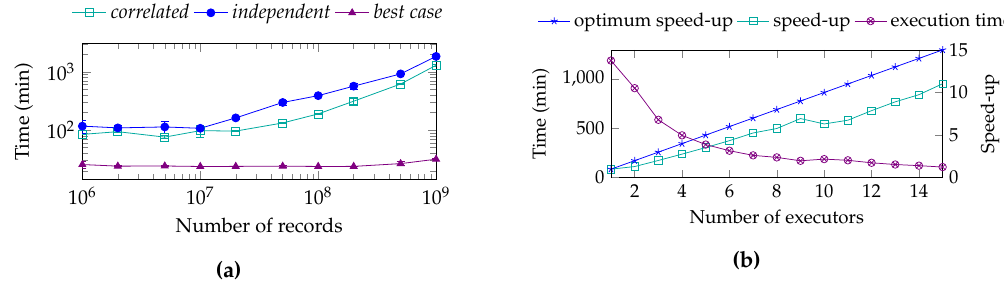
Figure 11. Performance evaluations for the pre-computation step (clustering, clusters and meta-links, single-aggregate selections and insertion into HBase). ( a ) Execution time for the three datasets and varying number of records; ( b ) Scalability evaluation for the correlated dataset with 10 7 records. The speedup is relative to a sequential